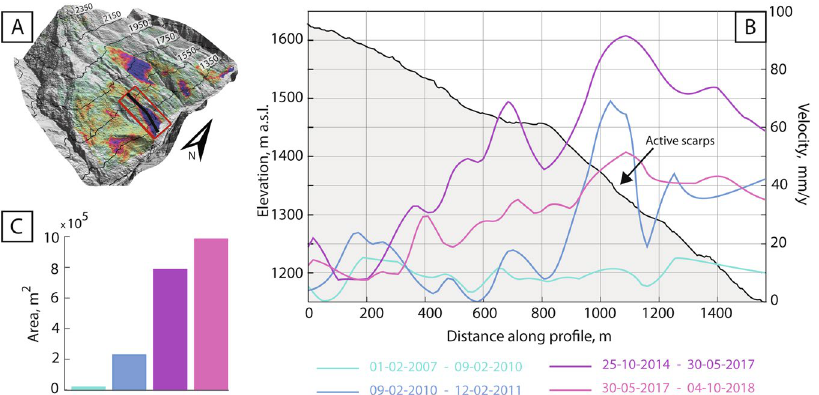
Figure 3. ( A ) 3D map inset shows the sum of cumulative displacements (stack) of all sensors over the entire slope, in red polygon the area of sector B and in black the profile are shown. ( B ) Velocities along the profile intersecting sector B. Slope profile shown in black. The different colours represent four periods over which velocities are calculated. ( C ) Histogram of the active displacements area size. (ALOS-1 and ALOS-2 SAR imagery obtained from JAXA (Dataset ©JAXA/METI ALOS PALSAR L1.0 2007, 2008, 2009, 2010, 2011, 2014, 2015, 2016, accessed through https://auig2.jaxa.jp/openam/UI/Login, 2016 and 2017). Copernicus